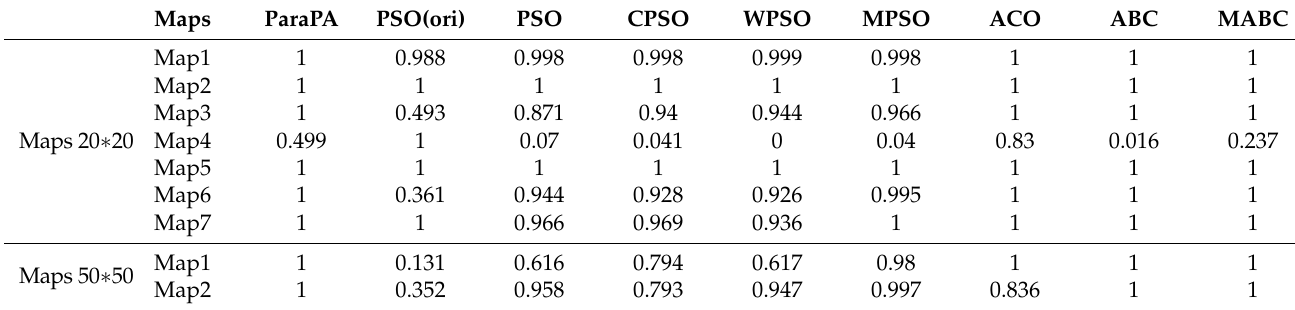
Table 2. Success rate on various